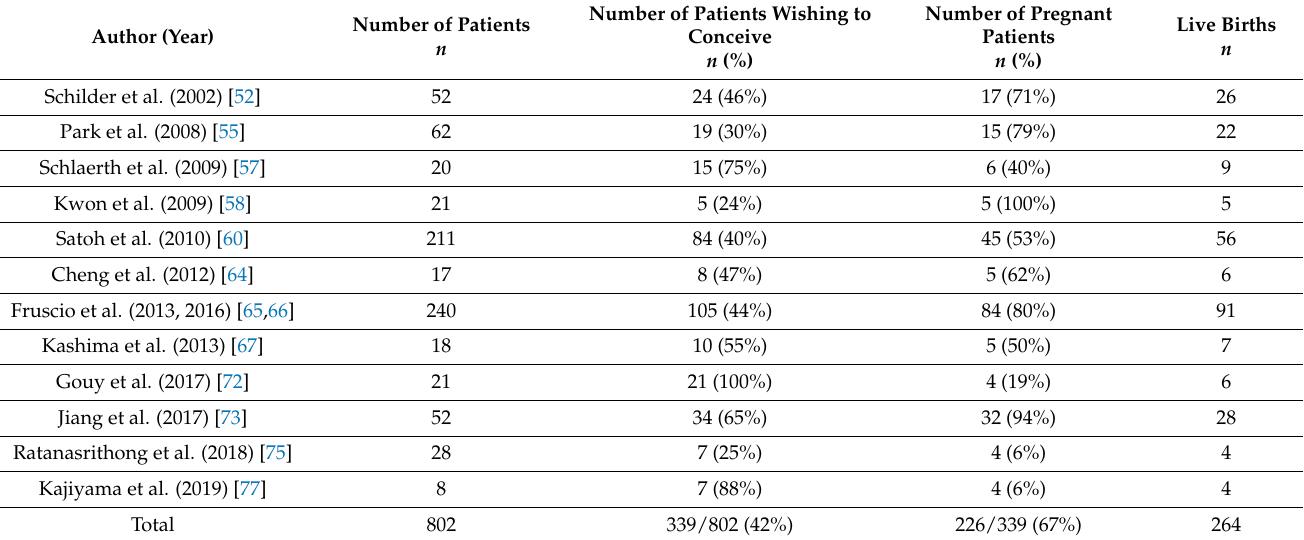
Table 3. Fertility outcomes after fertility-sparing surgery for patients treated for epithelial ovarian